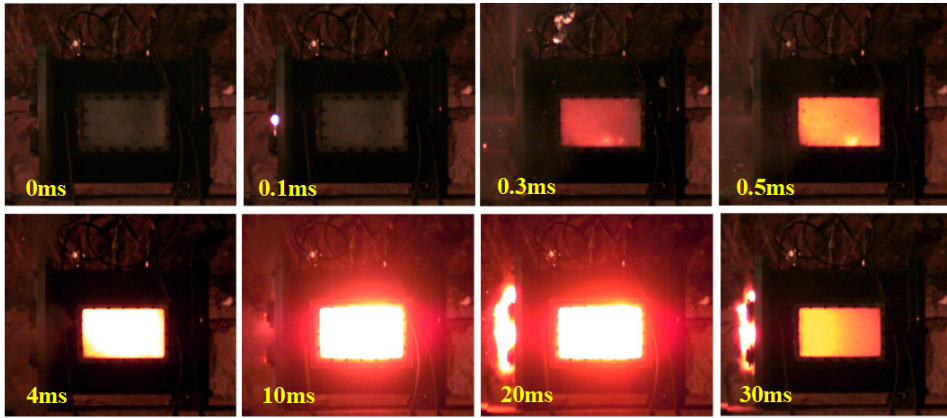
Figure 6. Typical frames of PTFE/Al/oxide (30% Bi 2 O 3 , v = 944.3 m/s) energy release process.